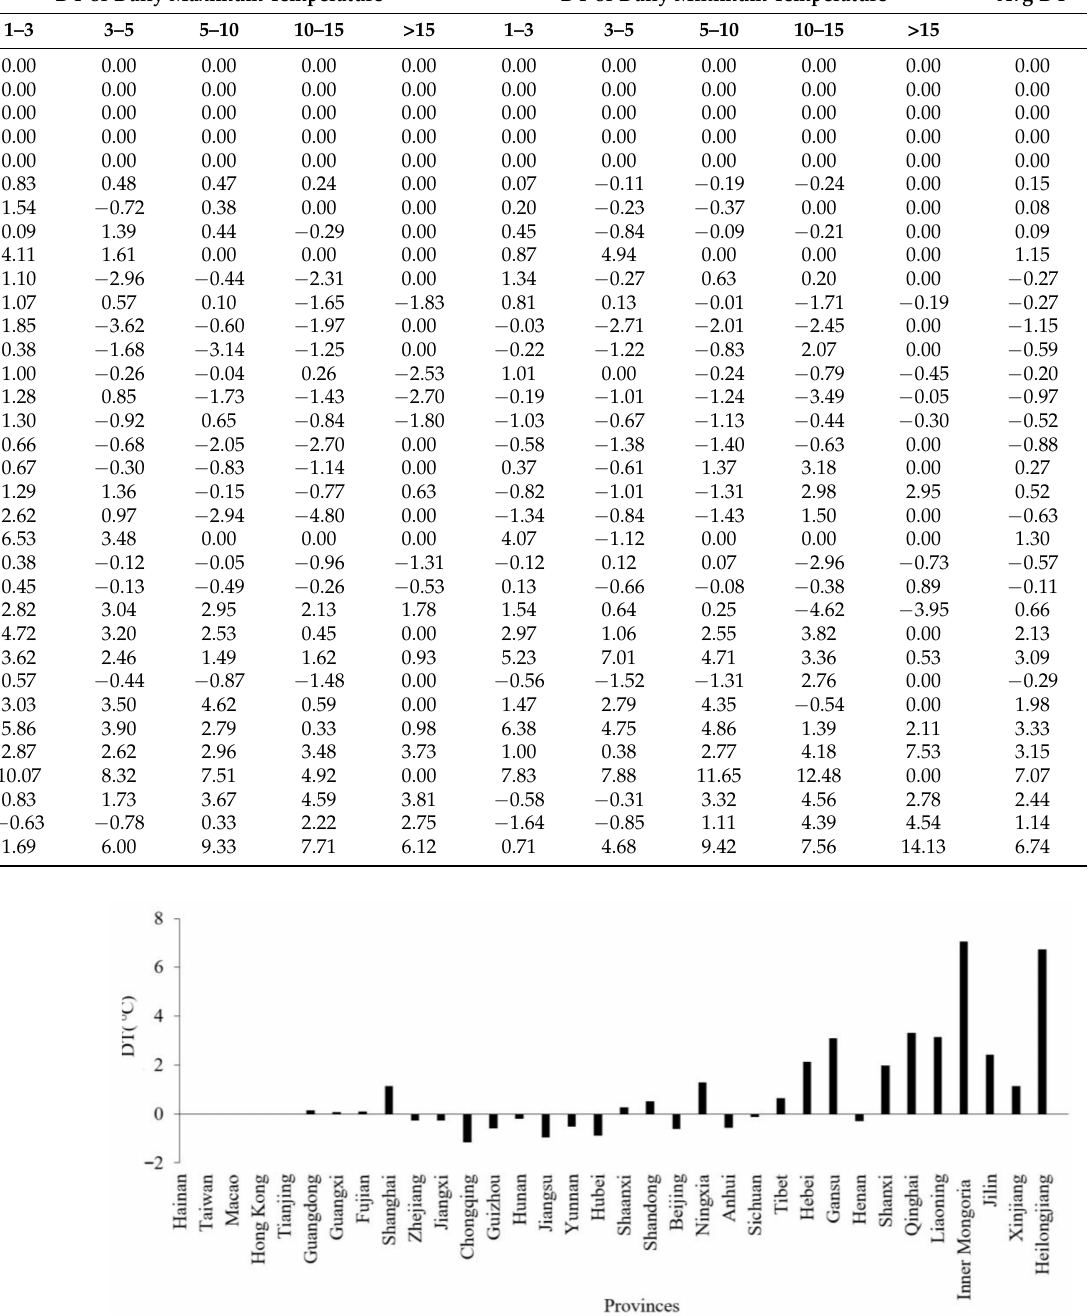
Figure 17. Average difference in temperature (DT) between the GFDL-ESM2G model and meteoro- logical station observations for each province during snowfall